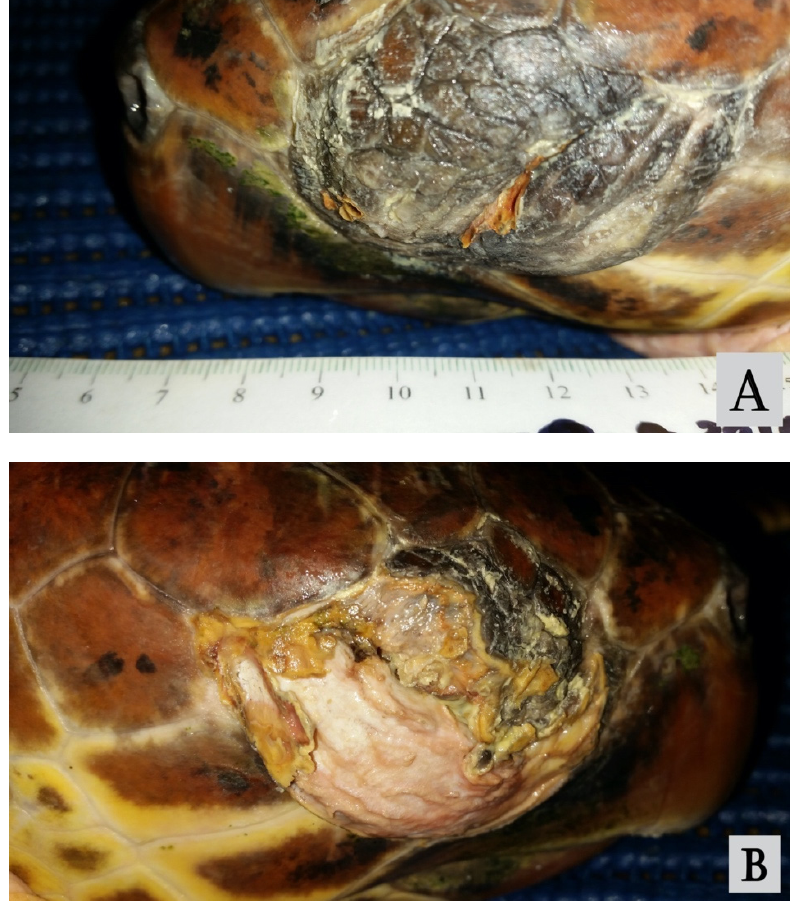
Figure 1. The left ( A ) and right ( B ) eyes at initial presentation, showing swollen, ulcered, and unseparable